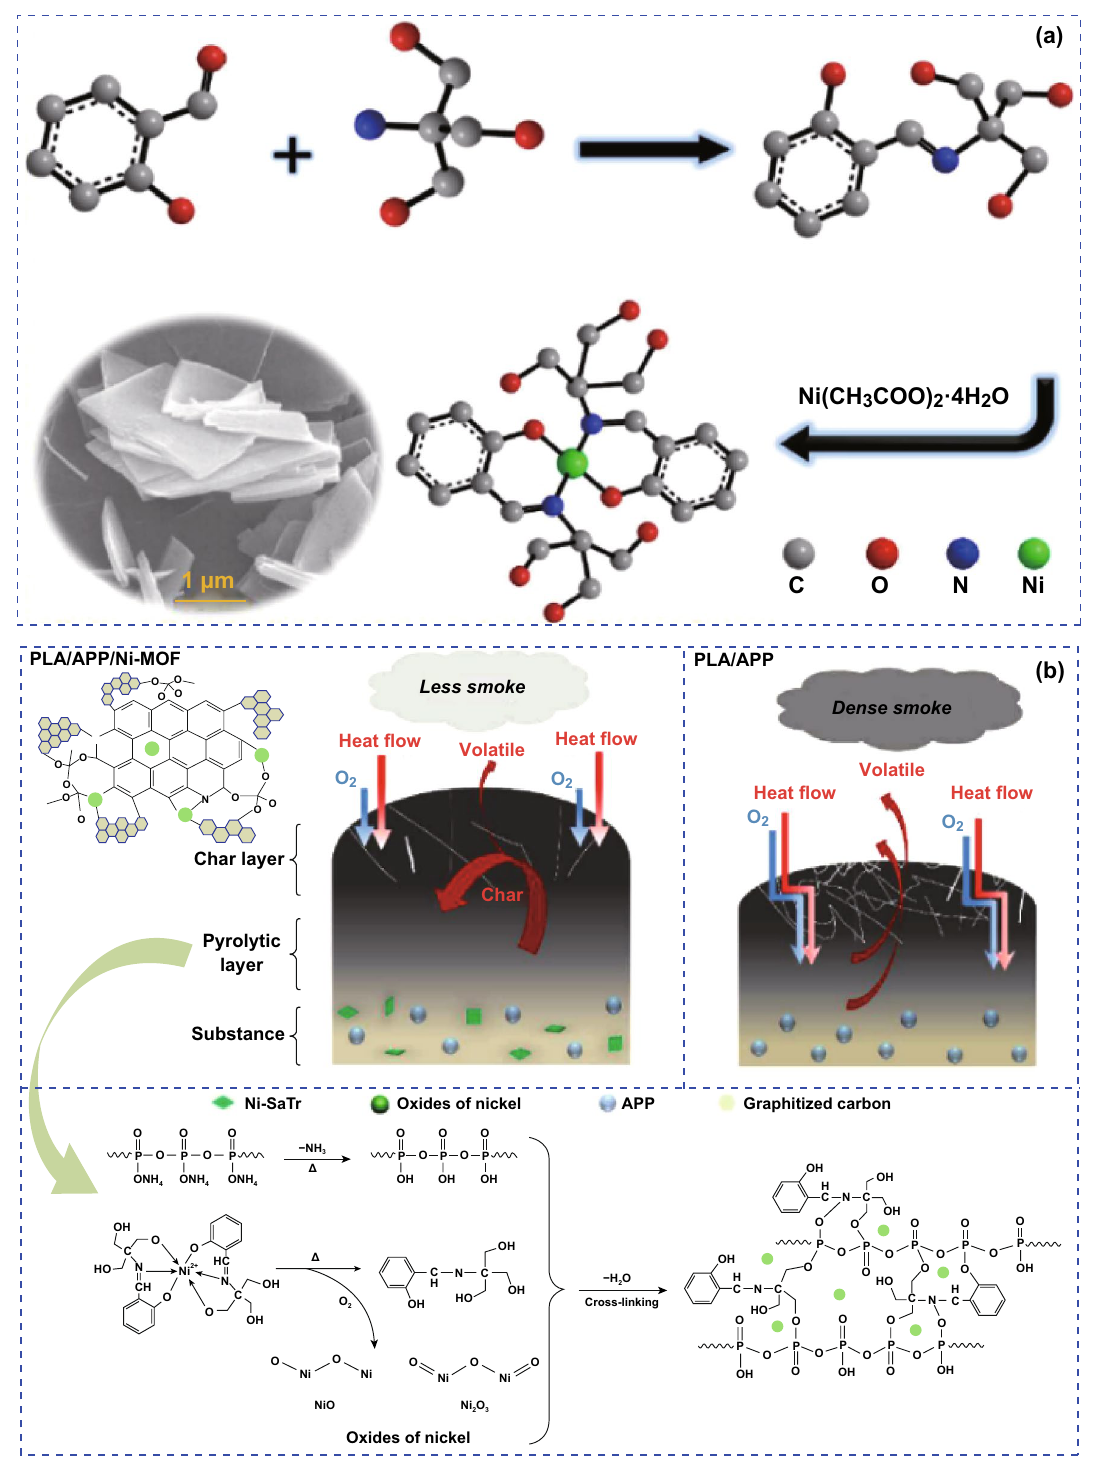
Fig. 18 a Graphic illustration of preparation process of Ni‑MOF. b Illustration of flame‑retardant and smoke suppression mechanism. Adapted from Ref. [43] with permission from